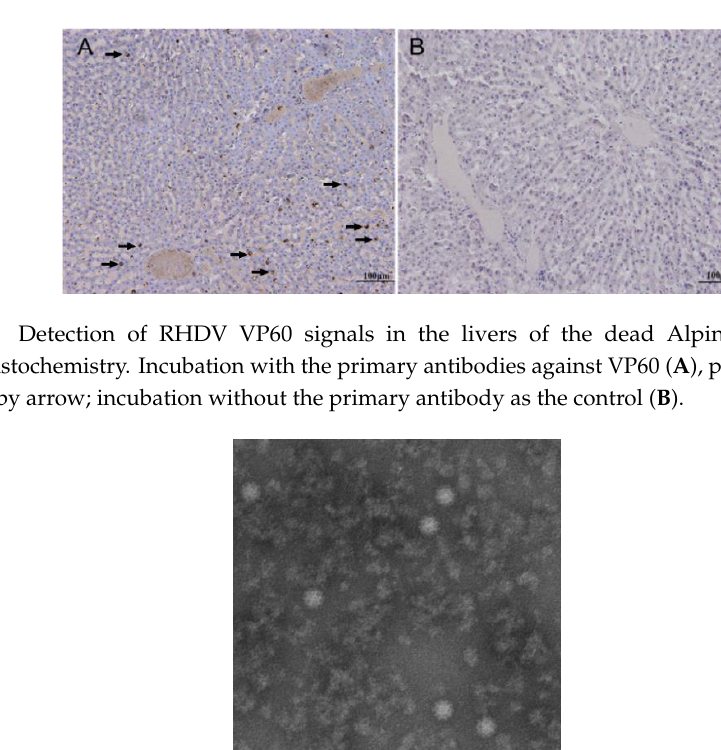
Figure 2. Histopathological lesions observed in diseased Alpine musk deer. Lung ( A ): moderate, diffuse congestion in alveolar capillary and blood vessels, extensive hemosiderin deposition, and dilation of bronchioles; liver ( B ): vacuolar degeneration of hepatocytes in the central zone of the lobule, karyopyknosis and karyolysis in some hepatocytes, and mild sinusoidal dilation and congestion; spleen ( C ): disorganization of the splenic architecture, extensive necrosis and atrophy of the white pulp with severe lymphocyte depletion, and moderate hemorrhage in the parenchyma; kidney ( D ): congestion of interstitial blood vessels, microthrombosis in the glomerular capillaries, and degeneration and karyopyknosis in numerous tubular epithelial cells. (H&E, 100×).